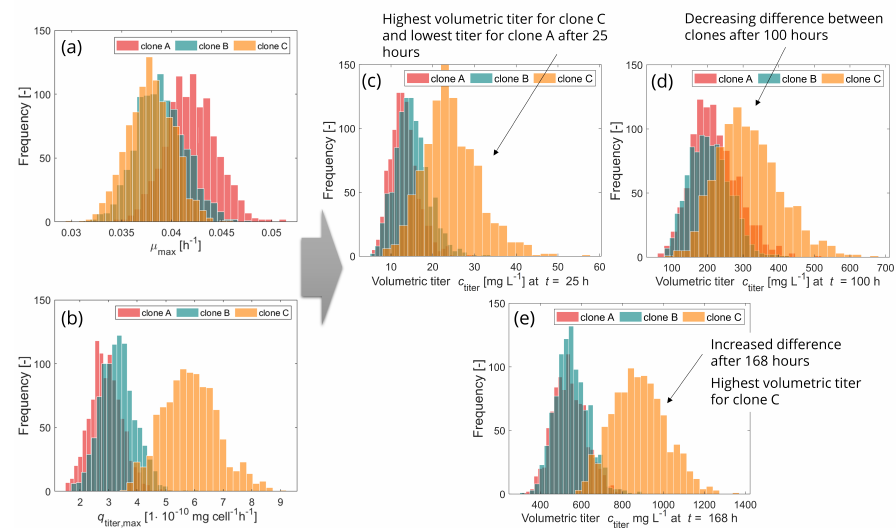
Figure 7. Histograms of inputs and outputs for clone A in the background (red), clone B in the middle (turquoise) and clone C in the front (orange). Inputs: Probability distributions of maximum growth rate ( a ) and maximum production rate ( b ) for three different clones. Probabilities are defined by the given means µ max and q titer,max and the corresponding coefficients of variation (cv). Outputs: Probability distributions of volumetric titer after 25 ( c ), 100 ( d ) and 168 ( e ) hours for the three